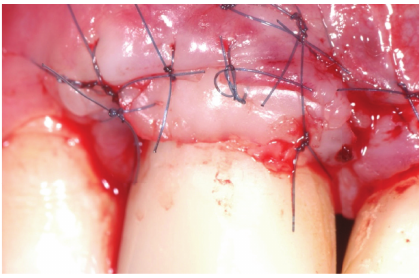
Figure 18: Combined soft tissue graft in situ.